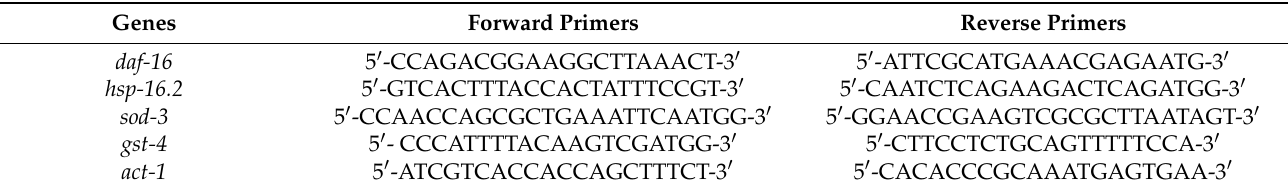
Table 3. The primers used for qRT-PCR